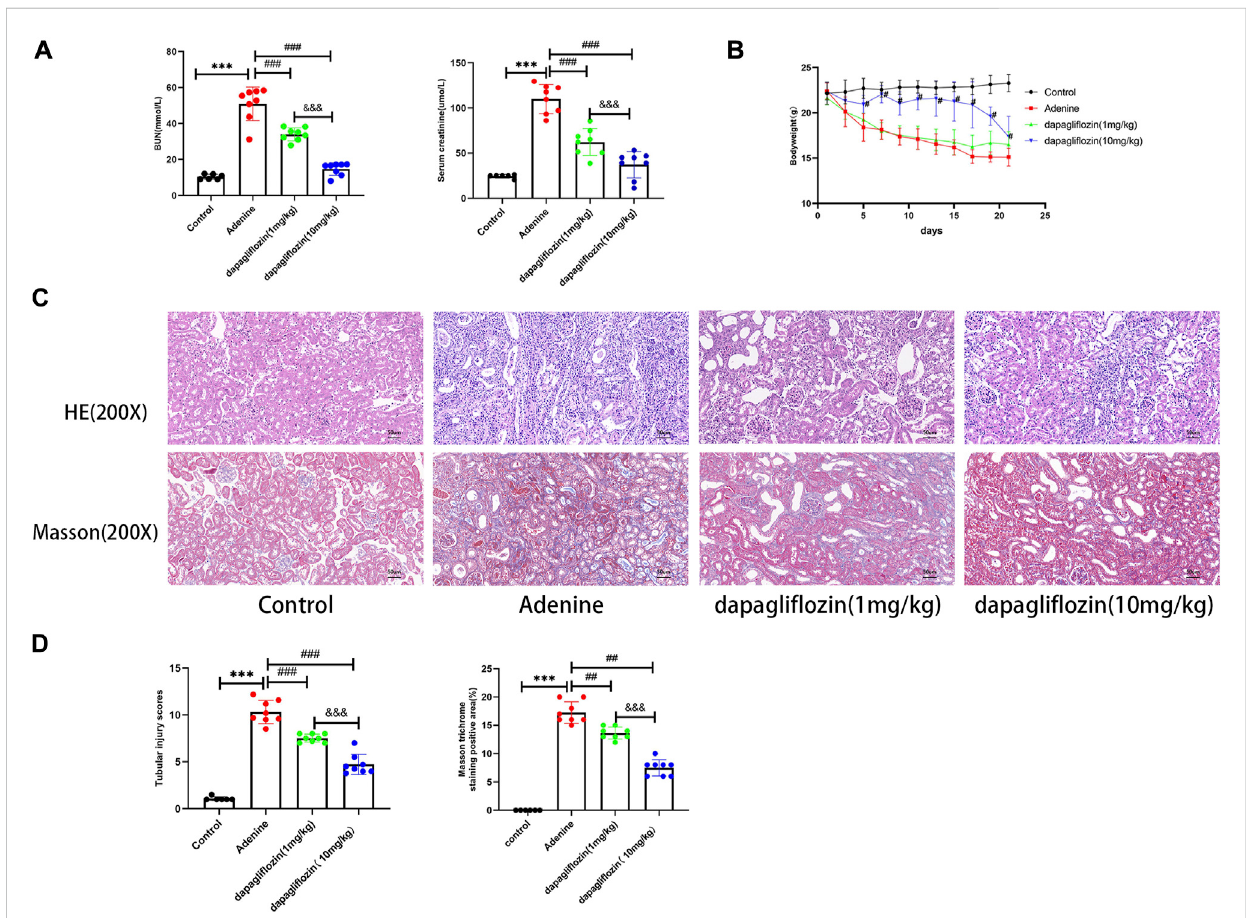
FIGURE 1 Dapagli fl ozin reduced renal fi brosis in 0.2% adenine diet-fed mice. (A) Serum urea nitrogen (BUN) and creatinine levels in each group. (B) Body weight variation of mice in each grough. (C) HE and Masson staining of renal tissues from each group. (D) Renal HE and Masson scores of each group. Scale bars, 50 μ m for all groups. Values are means ± SD. *** p < 0.001 adenine diet group compared with control group; ## p < 0.01 dapagli fl ozin treatment group compared with adenine diet group; ### p < 0.001 dapagli fl ozin treatment group compared with adenine diet group; p <